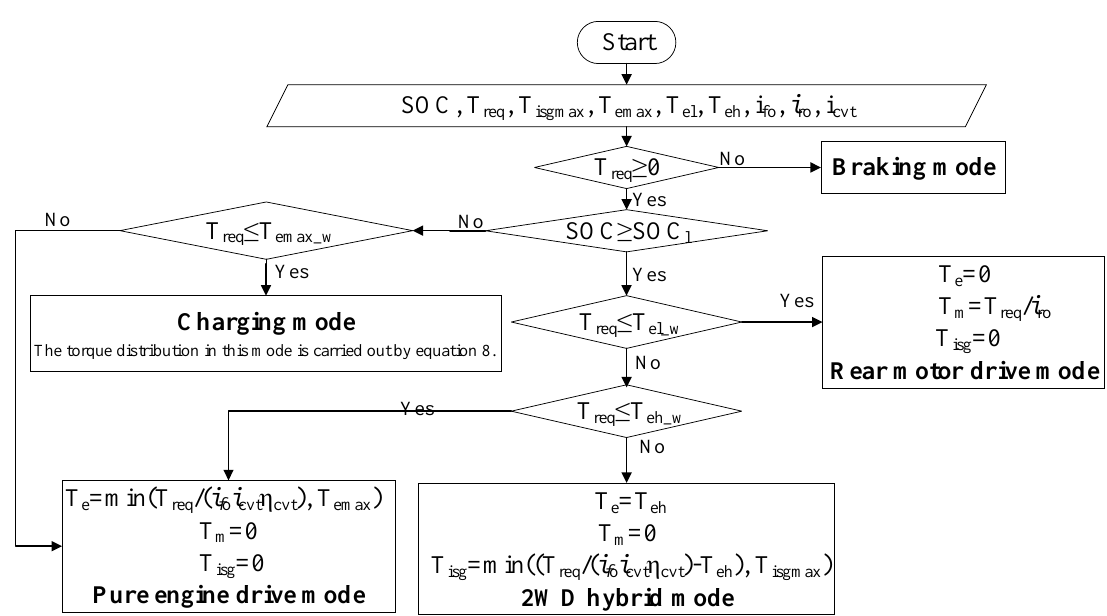
Figure 6. Control strategy in charge sustain (CS) mode.